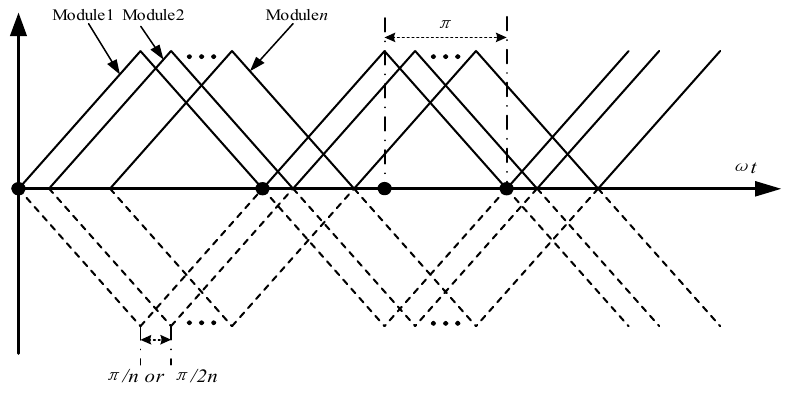
Figure 5. Carrier Phase Shifted SPWM for NPC Cascaded Inverter.